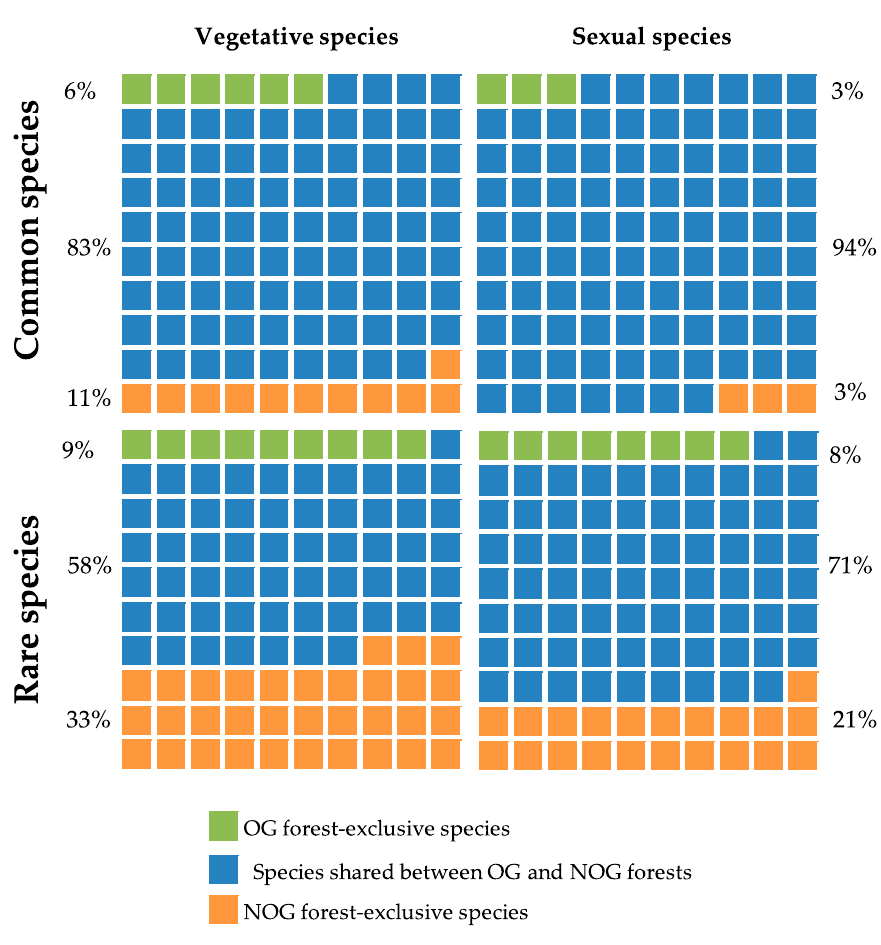
Figure 3. Schematic representation of shared and exclusive species in the OG and NOG forests of the study area (dataset without the species occurring only in a single plot, 34 species). The definition of “common” or “rare” species follows their commonness–rarity values in montane and humid sub-Mediterranean Italy (Nimis 2016). Table 2. Descriptive statistics of lichen species richness: alpha diversity (average number of species on each tree within a plot) and gamma diversity (average overall number of species within a plot). Results of the Wilcoxon test performed for the two groups of plots are also reported. n.s.: not significant ( p >